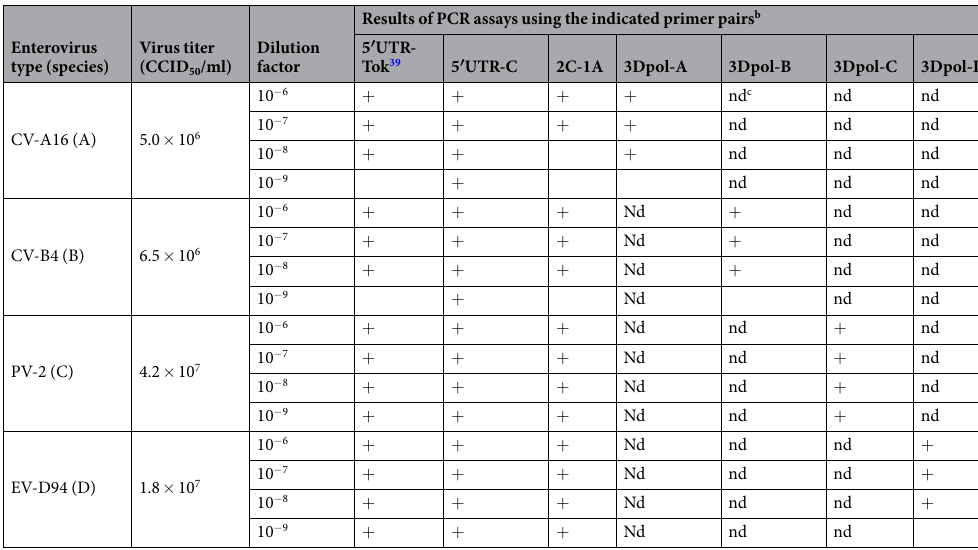
Table 2. End-point RT-PCR assays. Biologic titer of EV members of the A, B, C, D species and sensitivity of selected primer pairs a . a Virus titer is expressed as cell culture infectious doses 50 /ml (CCID 50 ). Total RNA was extracted from appropriate virus dilutions in cell culture medium and reverse transcripted. PCR assays were then run as reported in Methods. b Results of end-point RT-PCR. Positivity assigned to visible bands of the expected size in 2.2% agarose gels. c nd, not done.